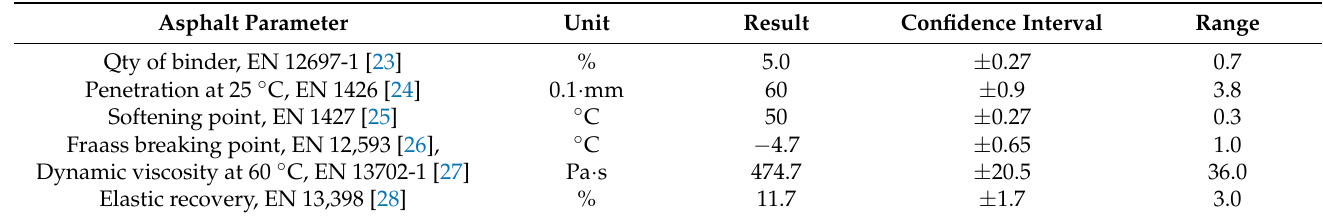
Table 1. Results of conventional tests of asphalt extracted from recycled material with confidence intervals.